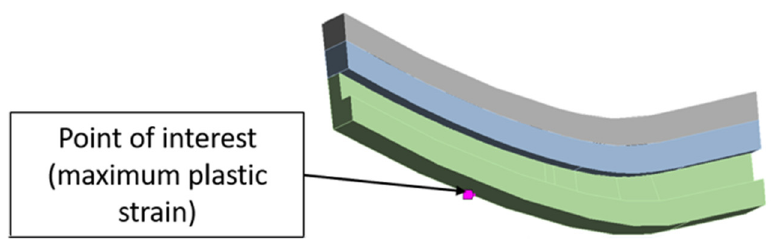
Figure 9. Location of the node with the maximum equivalent plastic strain value.